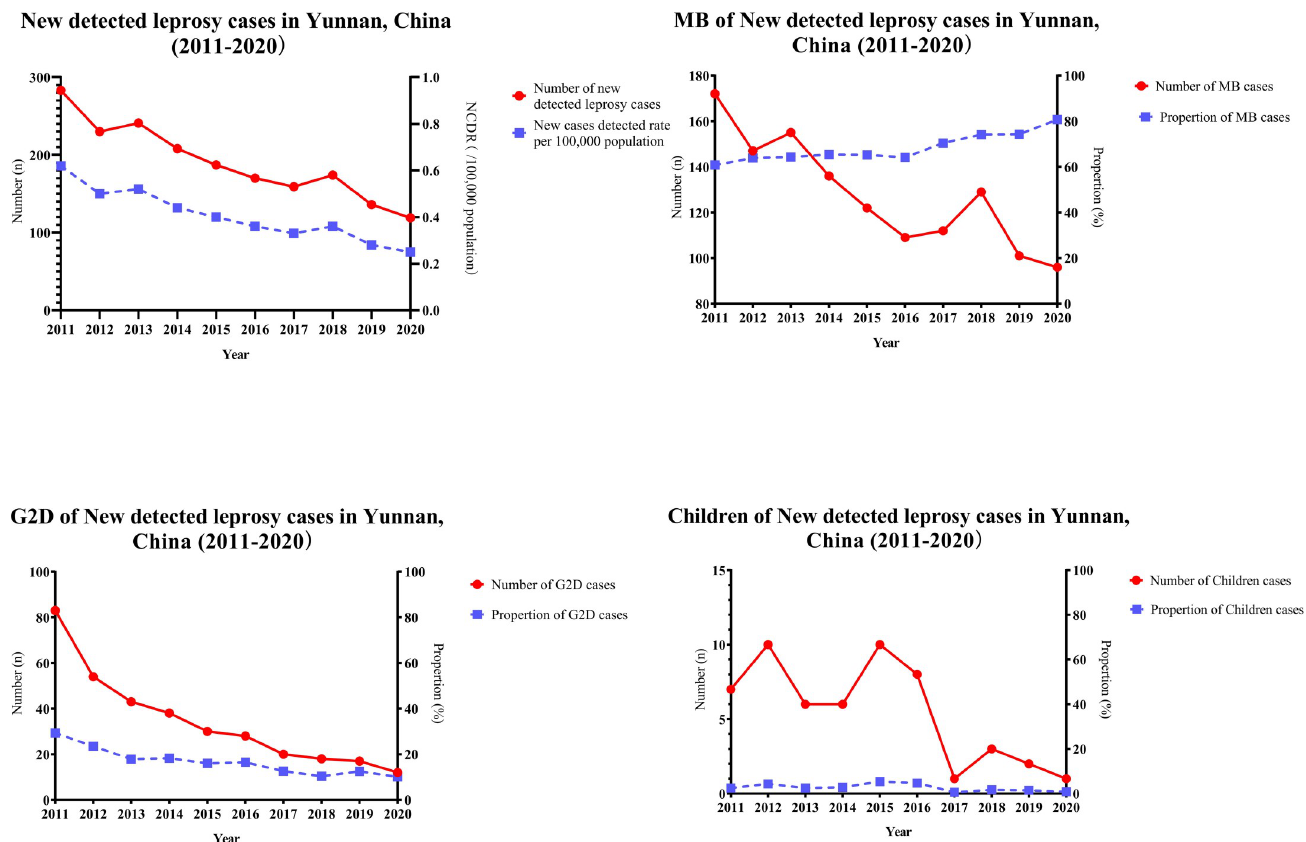
Fig 1. Epidemiological Characteristics of new detected leprosy cases in Yunnan, China, 2011–2020.